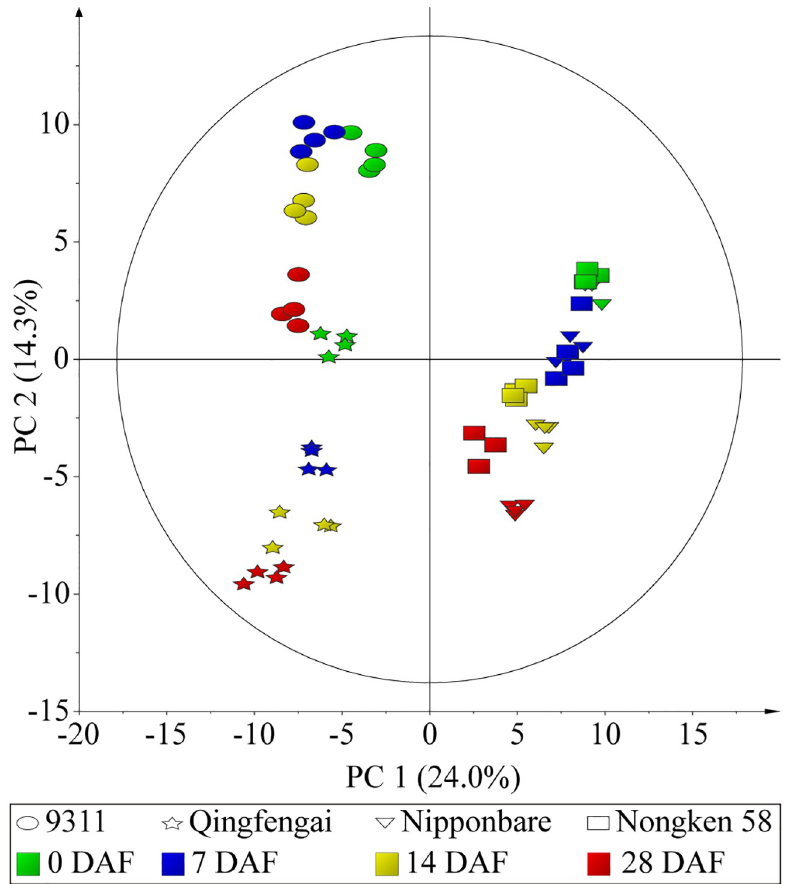
Fig 1. Principal component analysis (PCA) of the metabolomes of flag leaves. Green, blue, yellow and red colors represent samples at 0, 7, 14 and 28 DAF, respectively. Ellipse, star, triangle and square denote leaf metabolomes of 9311, Qingfengai, Nipponbare and Nongken 58, respectively. PC 1 explains 24.0% of variance distinguishing flag leaves of two japonica from those of two indica . PC 2 accounts for 14.3% of total variance separating leaf samples from different time